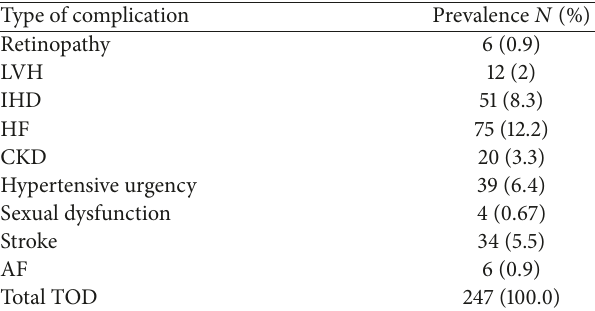
Table 3: The overall prevalence of TOD in hypertensive patients.